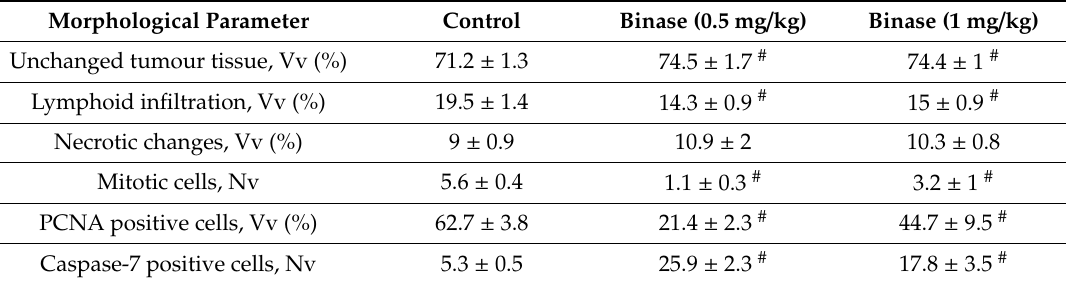
Figure 4. Mitoses, PCNA- and caspase-7-positive cells in RLS 40 tumour tissue after the binase administration. Representative histological images of tumour sections. Haematoxylin and eosin staining ( A ) and immunohistochemical staining with anti-PCNA ( B ) and anti-caspase-7 ( C ) monoclonal antibodies. Mitosis events are indicated by black arrows. Magnification: ×400. Table 2. Morphological organisation of RLS 40 tumour